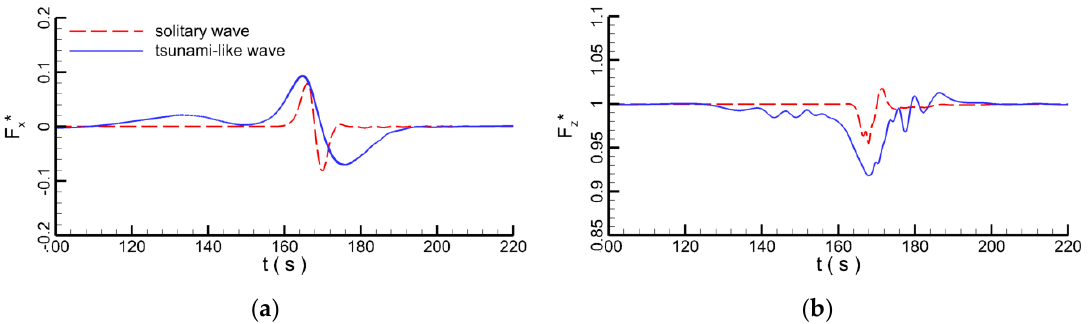
Figure 26. Temporal evolution of hydrodynamic forces at a pipeline when the gap-ratio equals 0.25;